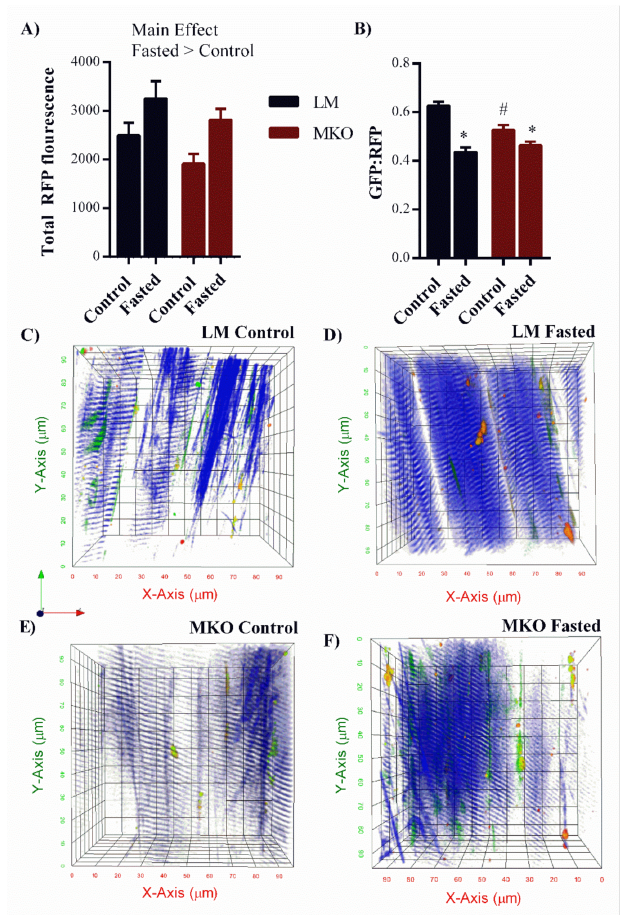
Figure 7. Altered autophagy flux response to fasting in young Ulk1 MKO muscles. ( A ) Quantification of total red fluorescence intensity in fasted and control MKO and LM muscles (Main effect of fasting, p = 0.003). ( B ) Green:Red fluorescent protein ratio after fasting compared to control levels of autophagosome degradation in Ulk1 MKO and LM muscles, Significant interaction ( p = 0.006) All data are presented as mean ± SEM * = significantly different from both control groups, # = significantly different from LM control. Representative two photon z-stack images taken from the TA muscle of ( C ) LM control, ( D ) LM fasted, ( E ) MKO Control, ( F ) MKO fasted mice. Green = LC3II incorporated into autophagosome membrane, Red = LC3II in cytosol, Blue = second harmonic generation labeling skeletal muscle contractile proteins for identifying muscle fiber